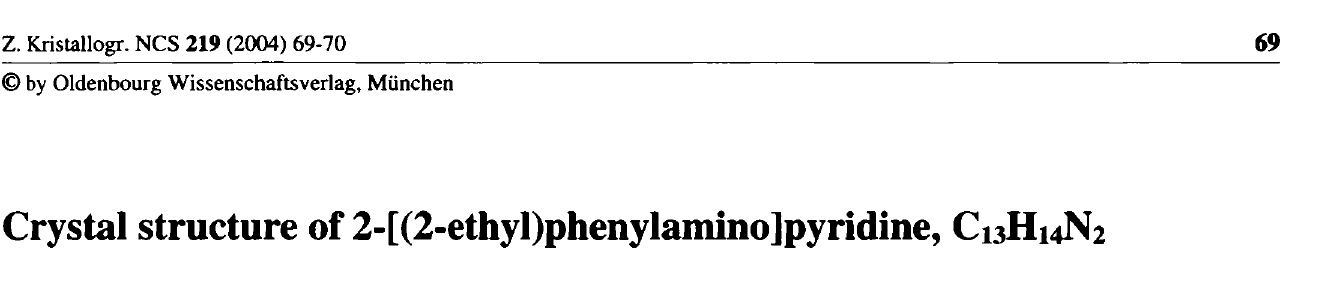
Table 1. Data collection and handling.